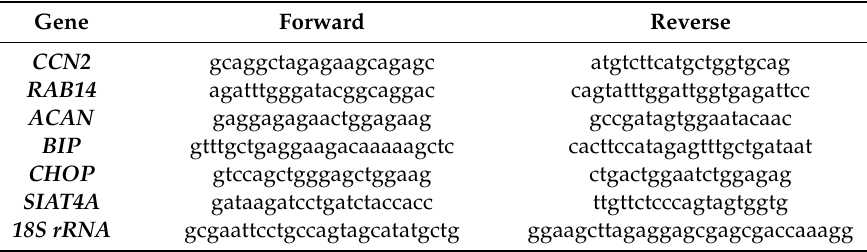
Table 2. Primer sequences for the human and monkey-derived cell line.